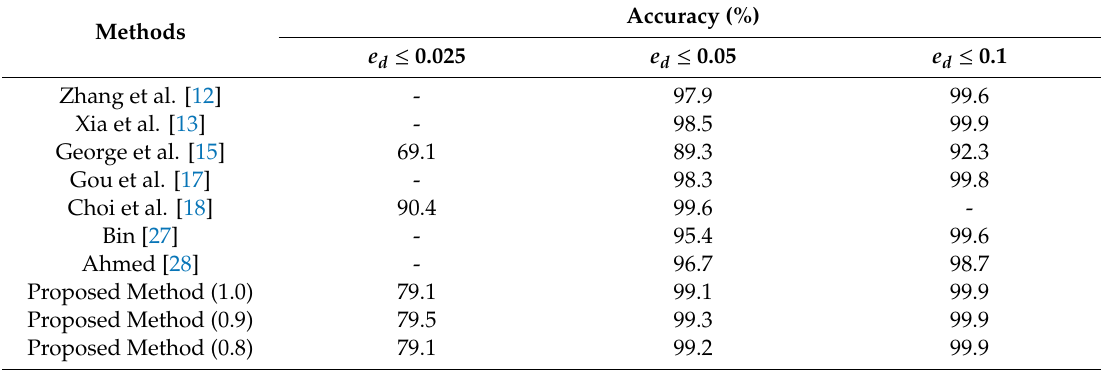
Table 4. Comparison of the accuracy with state-of-the-art methods using the GI4E dataset.